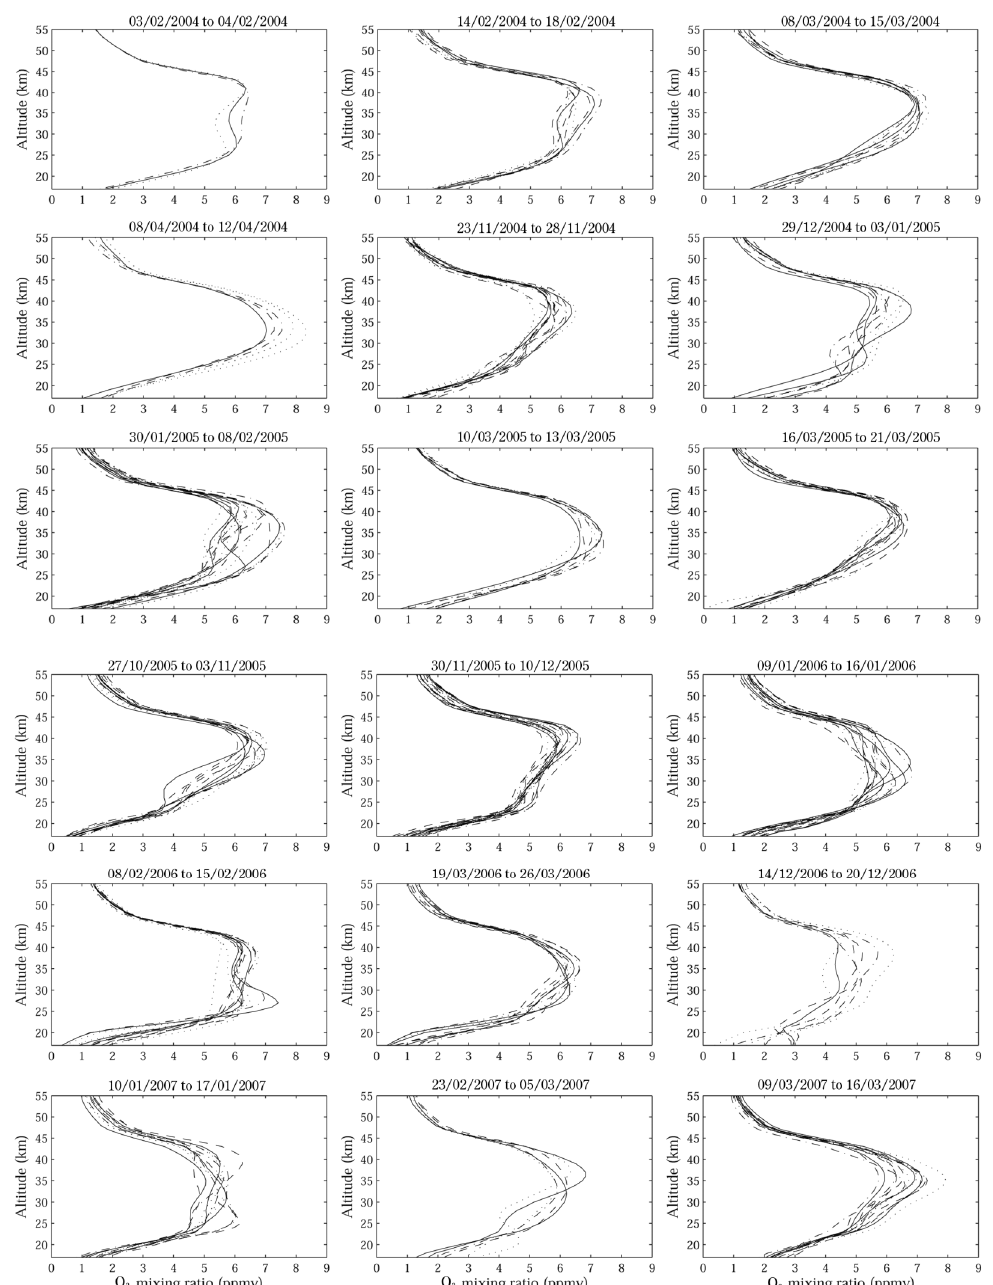
Fig. 5. GBMS O 3 mixing ratio vertical profiles from 17 to 55 km altitude from Testa Grigia. Each panel depicts measurements from one field campaign, with first and last day of measurements indicated at the top of each